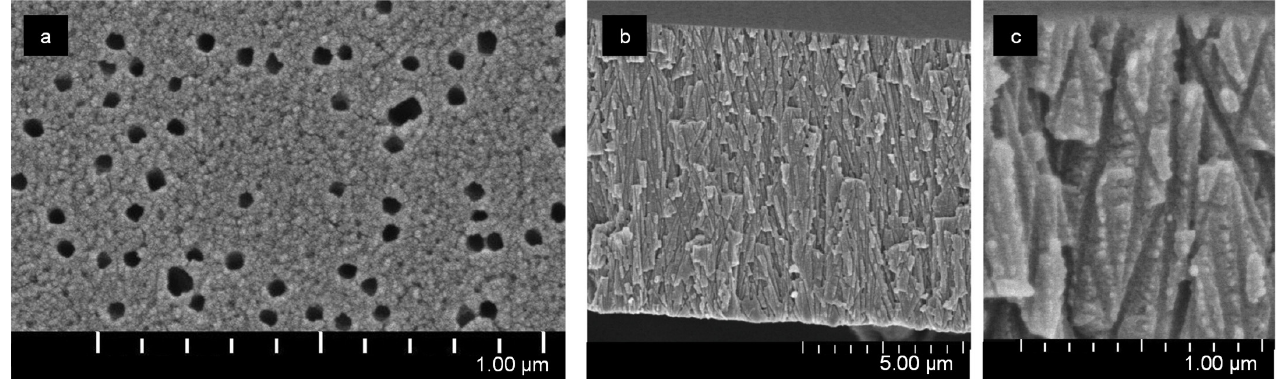
Figure 2. SEM images of surface ( a ) and cross section ( b , c ) of TEM#811.